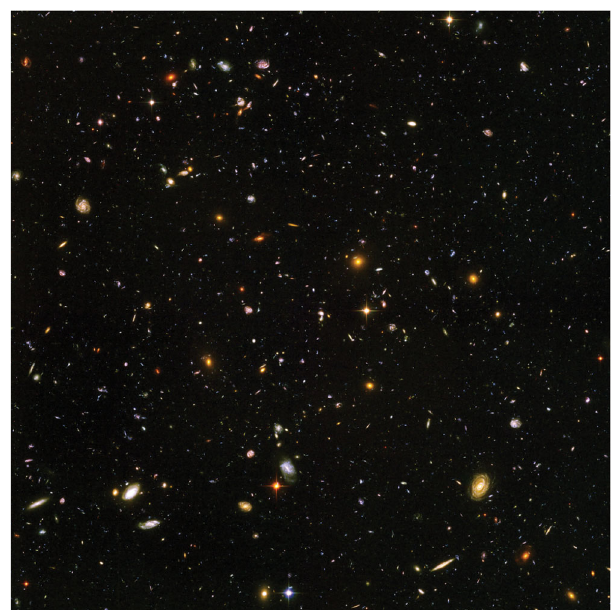
FIG. 6. Image of the Hubble Ultra Deep Field (HUDF). This image is a sight to behold, covering a patch of sky about 1 = 10 the angular diameter of the full Moon. The angular diameter of the full Moon is ½ degree. The image contains an estimated 10 000 galaxies, in a patch of the sky that appeared “ empty. ” Images like the HUDF are vital in providing a comparison of the evolution of galaxies in the early Universe (high-redshift) to galaxies as they are “ now ” (low redshift) like M104 in Fig. 4. Image credit: NASA, ESA, and S. Beckwith (STScI) and the HUDF